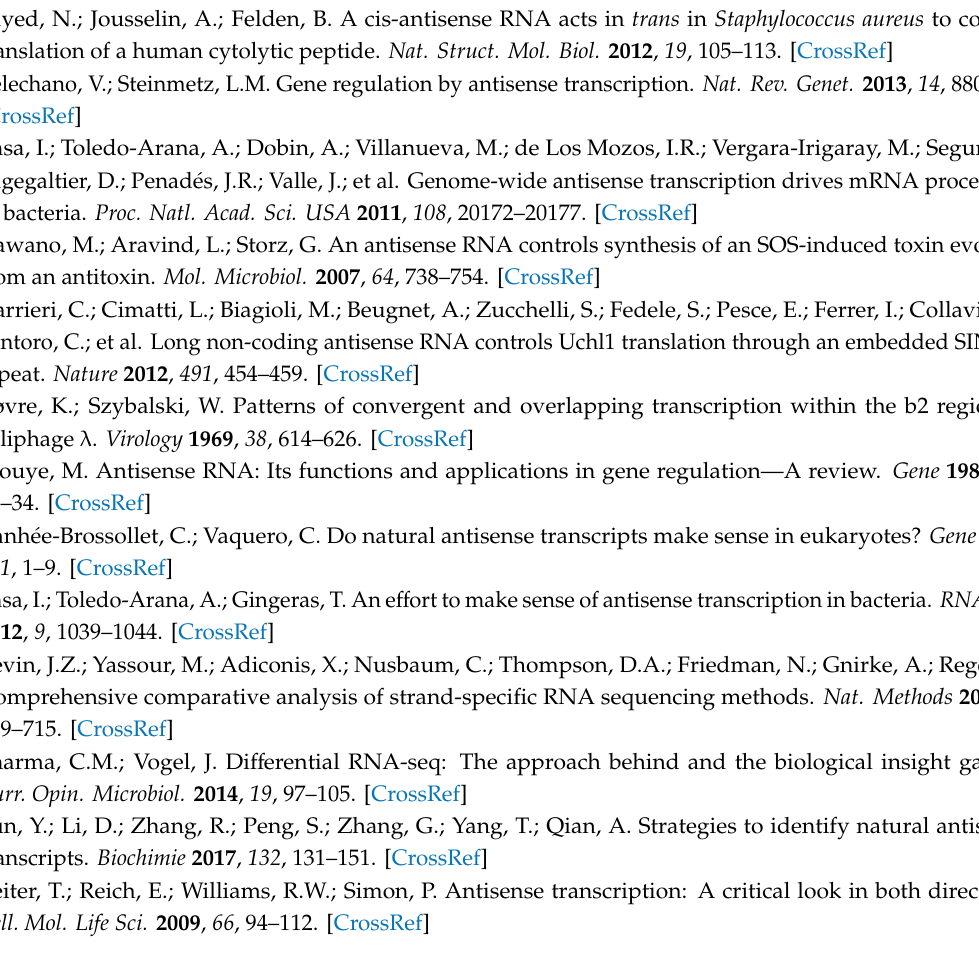
Table S10: asRNAs in genes related to translation, Table S11: asRNAs in genes encoding transposases, highlighted asRNAs overlap the 5 (cid:48) end of transposases, Table S12: Ribosome associated asRNAs, Table S13: aTSSs comparison between H. salinarum and H. volcanii, Table S14: Conserved asRNAs di ff erentially expressed in H. volcanii during oxidative stress Author Contributions: Conceptualization, T.K. and R.Z.N.V.; Methodology, R.Z.N.V., J.P.P.A., A.P.R.L., F.t.-C., AND J.V.G.-F.; Software: J.P.P.A., A.P.R.L., and R.Z.N.V.; Validation, J.P.P.A. and A.P.R.L.; Formal Analysis, J.P.P.A. and R.Z.N.V.; Investigation, J.P.P.A. and R.Z.N.V.; Resources, T.K.; Data Curation, J.P.P.A., A.P.R.L., and R.Z.N.V.; Writing—Original Draft Preparation, T.K., R.Z.N.V., and J.P.P.A.; Writing—Review and Editing, T.K., R.Z.N.V., J.P.P.A and A.P.R.L; Visualization, J.P.P.A.; Supervision, T.K. and R.Z.N.V.; Project Administration, T.K.; Funding Acquisition,